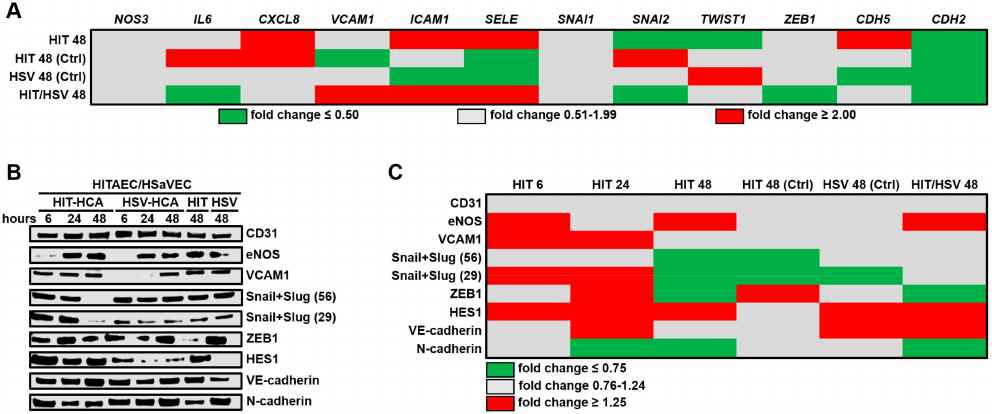
Figure 2. Profiling of key endothelial molecules in HITAECs (HIT) and HSaVECs (HSV) co-cultured with HCAECs for 6, 24, or 48 h. ( A ) RT-qPCR profiling, HIT signifies the ratio of transcript levels (measured as ∆ Ct) in HITAECs to those in HSaVECs co-cultured with HCAECs. HIT (Ctrl) and HSV (Ctrl) represent the ratios of transcript levels (measured as ∆ Ct) in HITAECs and HSaVECs co-cultured with HCAECs to those in the respective monocultures. HIT / HSV signifies the ratio of transcript levels (measured as ∆ Ct) in HITAEC to those in HSaVEC monocultures. Results are represented as the heat map; green, gray, and red colours indicate fold changes of ≤ 0.50, 0.51–1.99, and ≥ 2.00, respectively; ( B ) Western blotting measurements. HIT-HCA signifies HITAECs co-cultured with HCAECs, HSV-HCA abbreviates HSaVECs co-cultured with HCAECs. HIT and HSV represent HITAEC and HSaVEC monocultures, respectively. ( C ) Semi-quantitative analysis of Western blotting results by densitometry. HIT signifies the ratio of band density in HITAECs to that in HSaVECs co-cultured with HCAECs. HIT (Ctrl) and HSV (Ctrl) signify the ratios of band density in HITAECs and HSaVECs co-cultured with HCAECs to those in the respective monocultures. HIT / HSV signifies the ratio of band density in HITAEC monoculture to that in HSaVEC monoculture. Snail + Slug are shown at both 56 and 29 kDa values. Results are represented as green, gray, and red colours on the heat map, indicating fold changes of ≤ 0.75, 0.76–1.24, and ≥ 1.25,